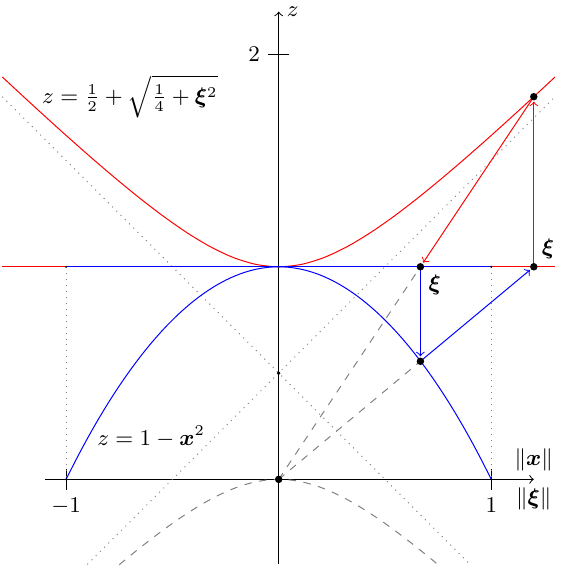
Figure 3. Interpretation of the distortion and undistortion functions for α = − 1 . Sensor plane and scene plane are at z = 1 . Undistortion: (1) parallel project x from the sensor plane along − z onto the paraboloid z = 1 − x 2 and (2) central project it back through the origin to ξ on the scene plane. Distortion: (1) parallel project ξ from the scene plane along z onto the upper (cid:113) 1 + + ξ 2 and (2) central project it half hyperboloid z = 1 2 4 back through the origin to x on the sensor plane. parameters and epipolar geometry in one step, cf. e.g. (Brito, 2017). In a similar way, one can also define a radial trifocal tensor or a radial homography matrix (Brito et al., 2013b, Kukelova et al., 2015).